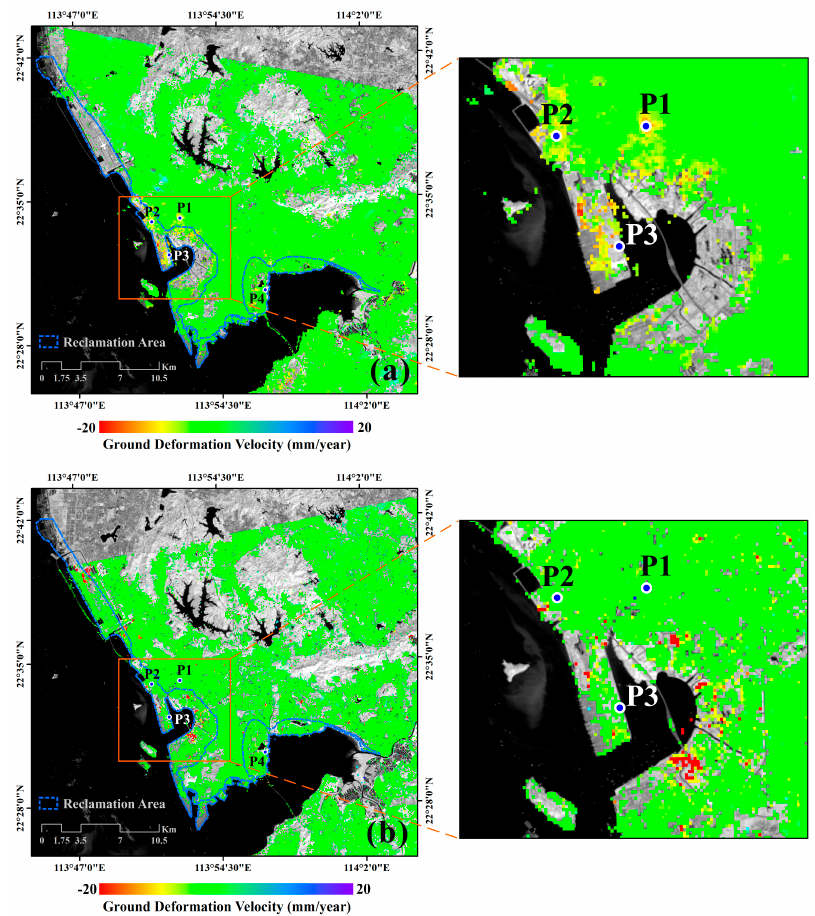
Figure 13. Shenzhen area results. ( a ) Map of masked Up–Down ENV deformation velocity from June 2007 to April 2010. ( b ) Map of Up–Down S1A deformation velocity from June 2019 to June 2020. The area within the blue curve is the reclamation area of Shenzhen.